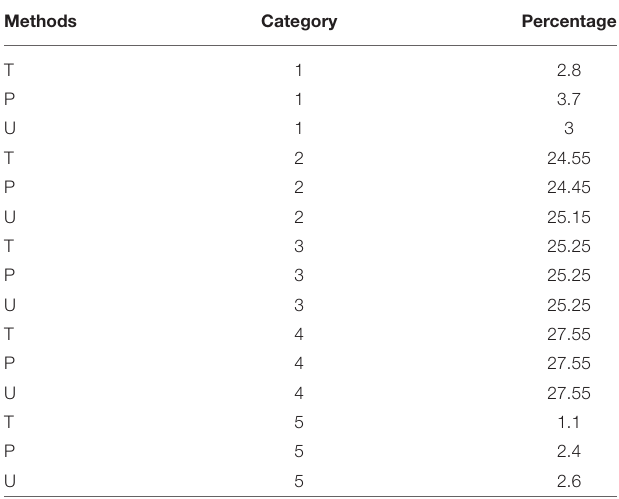
TABLE 2 | Misclassification rate for T, P, and U methods for test length of 30 with no item exposure control.